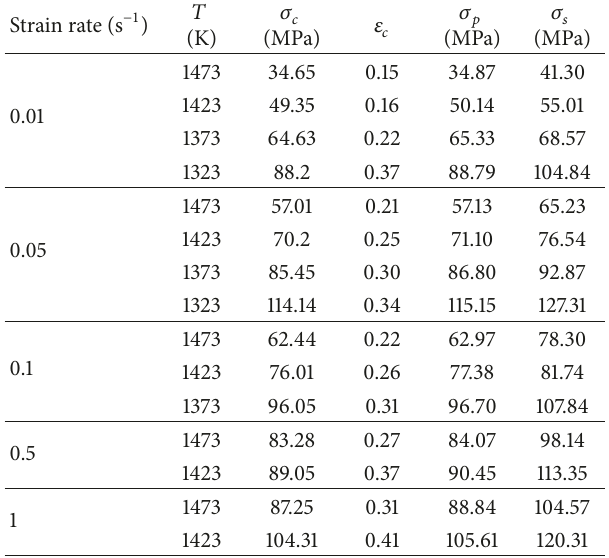
Table 1: The values of 𝜎 𝑐 , 𝜀 𝑐 , 𝜎 𝑝 , and 𝜎 𝑠 under different deformation